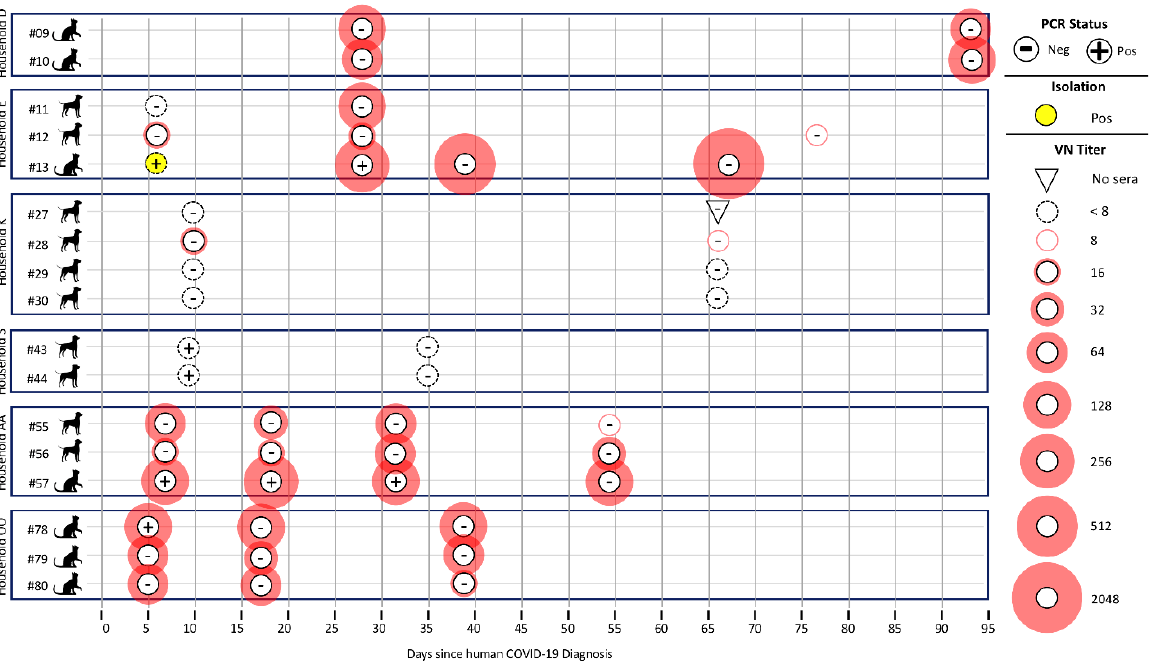
Figure 2. Multi-pet households in which at least one pet in the house was initially positive by PCR analyses or virus neutralization. All pets in the household were followed longitudinally to track duration of positive test results and changes in antibody titers over time. PCR status is based on preliminary screening Ct of <40 on RdRp, E, N1 and/or N2 gene target from any diagnostic swab type (respiratory, rectal, or body swab; positive results here do not necessarily indicate USDA case definition has been met. Virus neutralization titer was determined by a two-fold serial dilution of